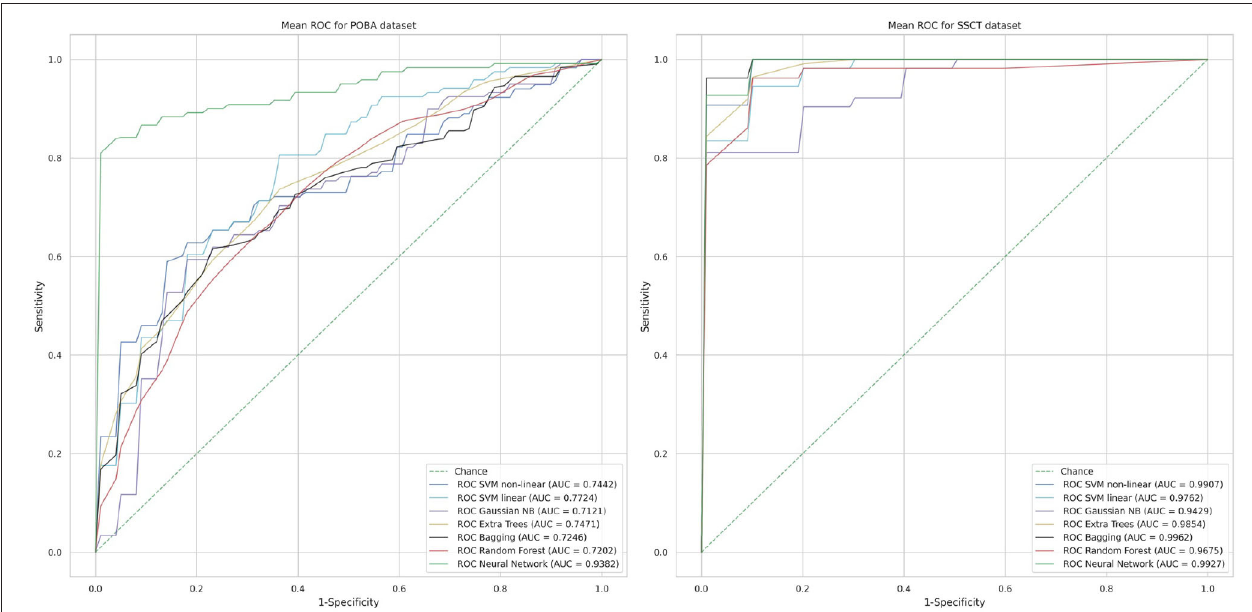
FIGURE 8 | Classification performance of each method in terms of the mean receiver operating characteristic curve using a stratified five-fold cross-validation technique (area under the curve values close to 1 indicate a high level of diagnostic rate, whereas a value close to 0.5 shows poor